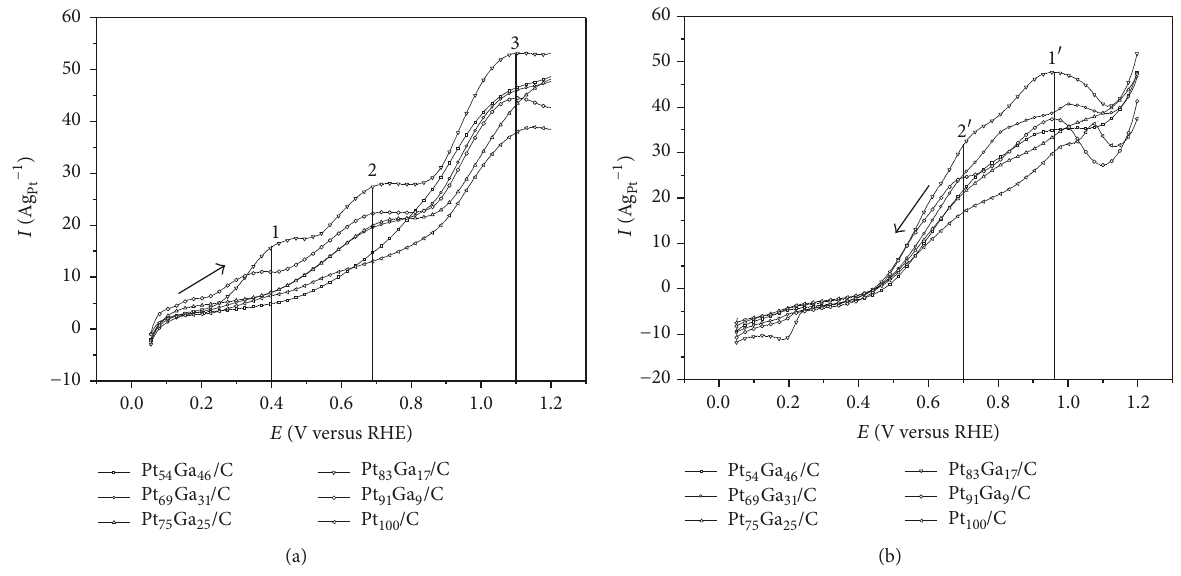
Figure 7: CV curves in the (a) positive-going scan and (b) negative-going scan for ethanol oxidation of the PtGa/C electrocatalysts in 1.0mol L −1 ethanol and H 2 SO 4 0.5 molL −1 supporting electrolyte, from 0.05 to 1.2 V versus RHE and scan rate of 50mVs −1 .